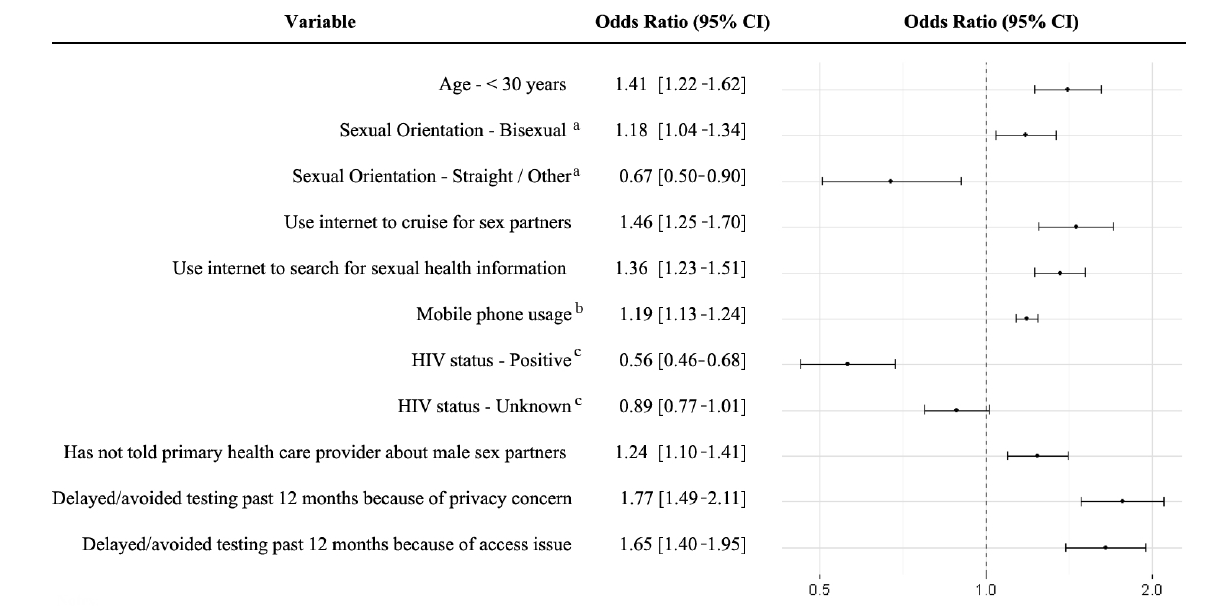
Figure 1. Correlates of intention to use Internet-based sexually transmitted infection testing selected by Bayesian Information Criterion in a survey sample of Canadian gay and bisexual men (N=7938). a Referent group Sexual Orientation - Gay; b Mobile phone usage measured on 3-point continuous scale; c Referent group HIV status - negative.